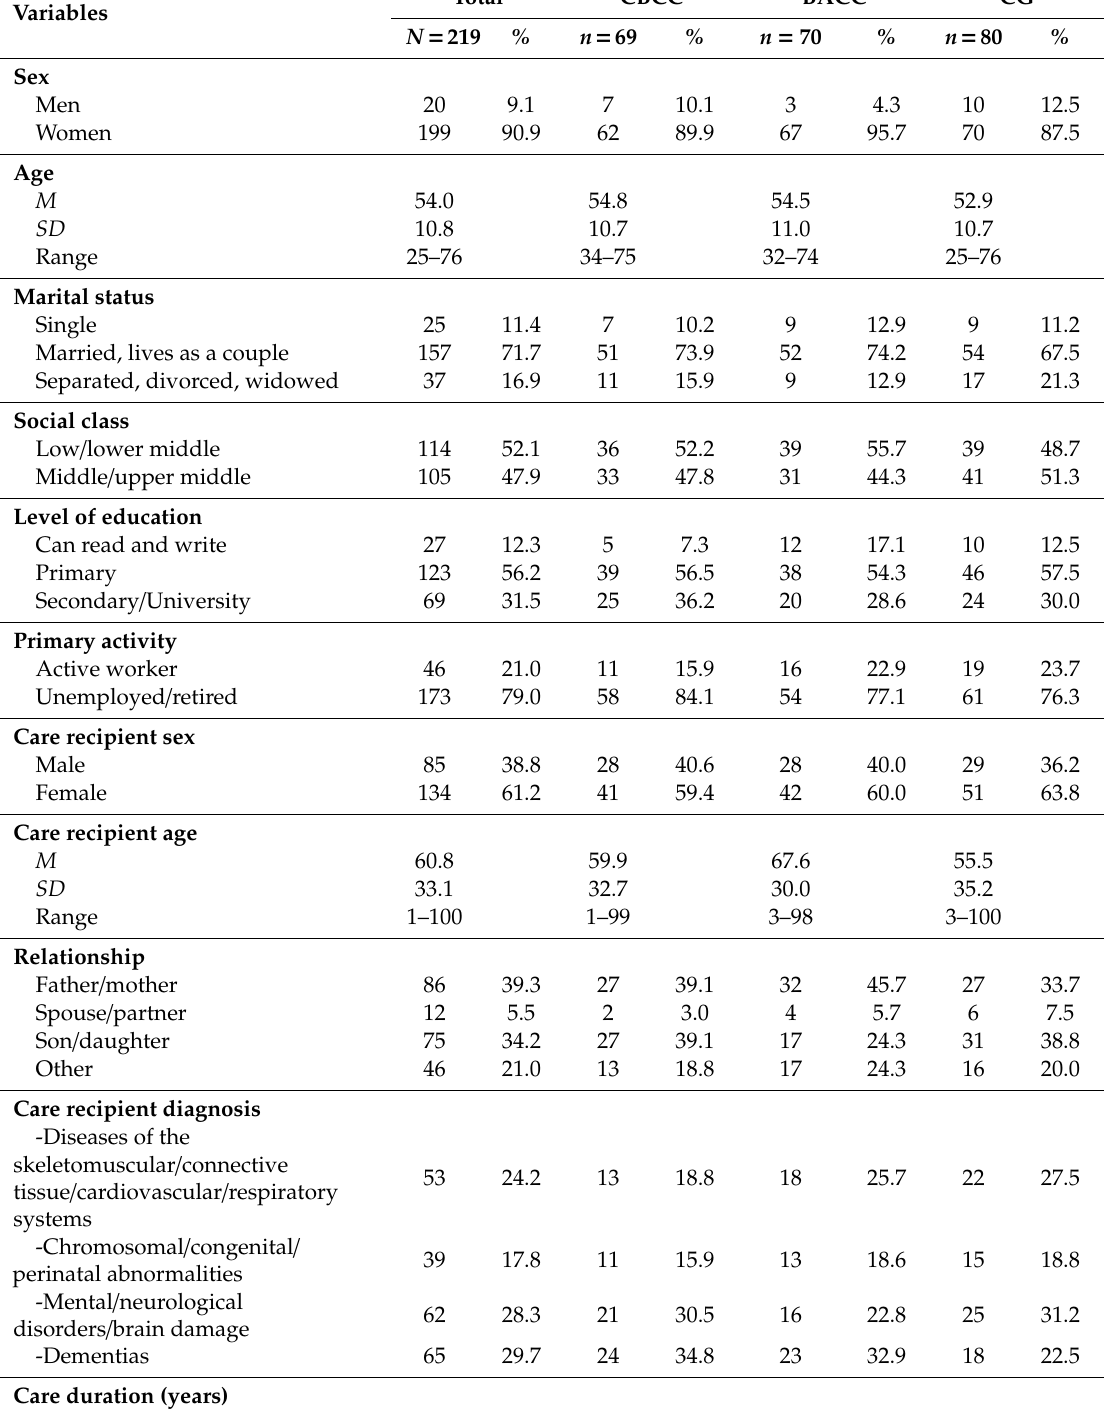
Table 1. Sociodemographic characteristics and the care situation for the